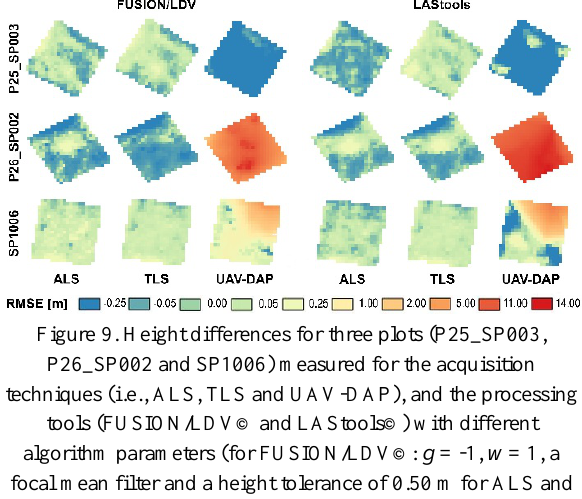
Figure 9. Height differences for three plots (P25_SP003, P26_SP002 and SP1006) measured for the acquisition techniques (i.e., ALS, TLS and UAV-DAP), and the processing tools (FUSION/LDV© and LAStools©) with different algorithm parameters (for FUSION/LDV©: g = -1, w = 1, a focal mean filter and a height tolerance of 0.50 m for ALS and UAV-DAP, and a height tolerance of 0.10 m for TLS; and for LAStools©: nature and